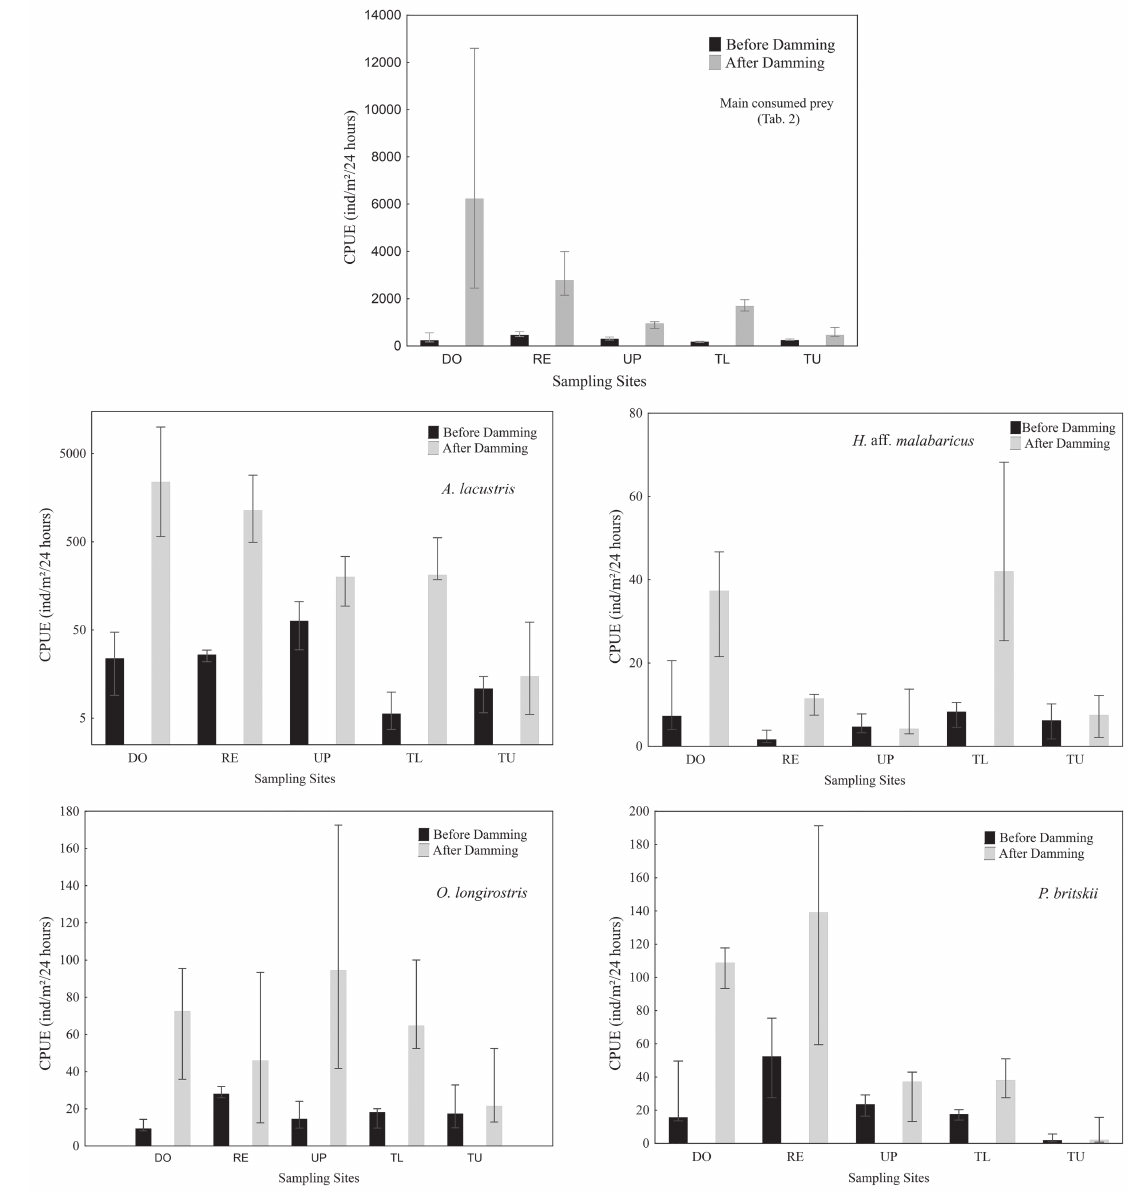
Fig. 2. Median abundance (Capture per unit effort - CPUE; unit: number of individuals/1,000 m² of nets set for 24 h) of the most consumed prey and analysed species from Iguaçu River in the Salto Caxias Reservoir area of influence, before and after damming (RE - reservoir region; DO - downstream; UP - upstream from the Iguaçu River; TL - tributaries lower section; TU - tributaries upper section). Vertical bars=Min and Max